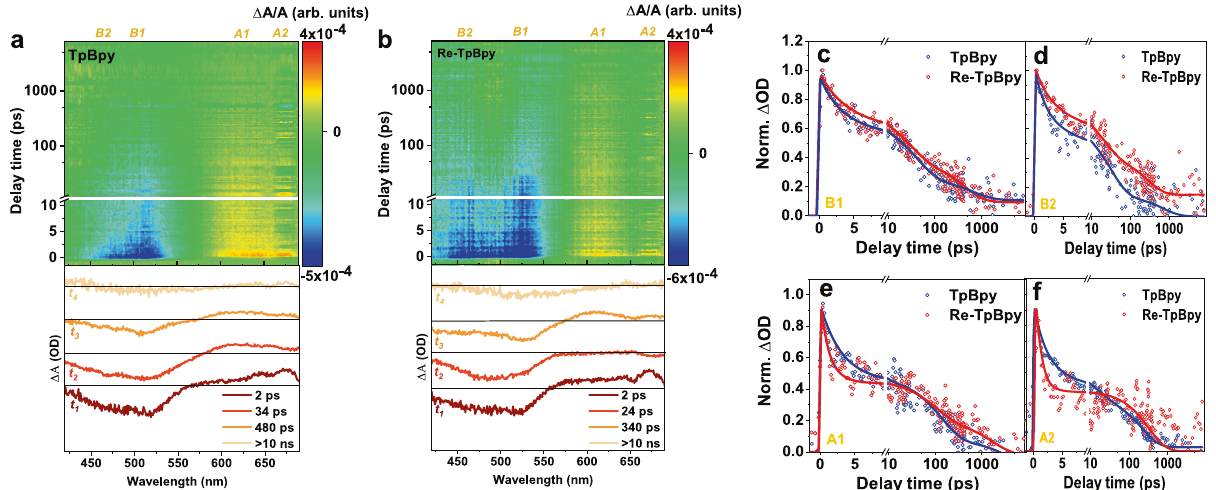
Fig. 6 TA study at high-energy excitation. TA spectra under 400 nm excitation at the fl uence of 2 × 10 13 ph/cm 2 and the respective SVD fi ttings of TpBpy ( a ), Re-TpBpy ( b ). TA kinetics of two samples at various emission wavelengths representing B1 ( c ), B2 ( d ), A1 ( e ), A2 ( f ). All spectra are recorded in Na fi on (5% w/w in water and 1-propanol). Source data are provided as a Source data fi